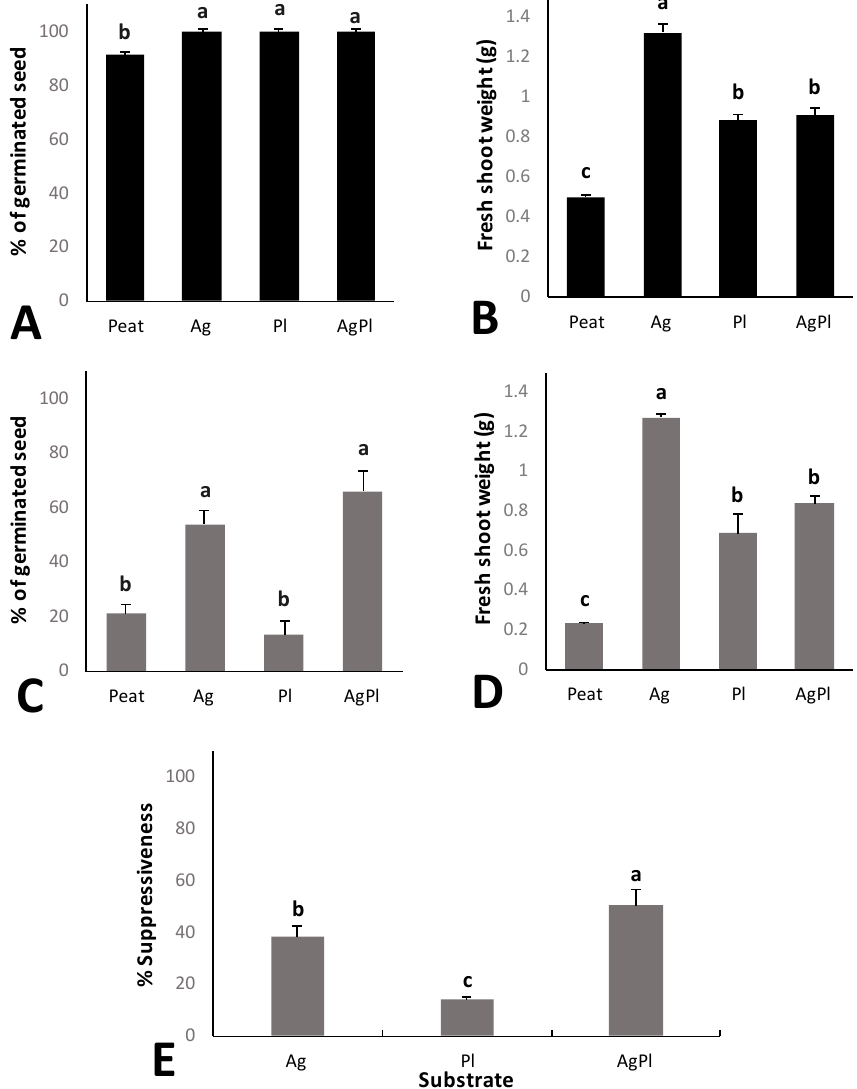
Figure 2. Germinated seed percentage ( A ) and fresh shoot weight ( B ) of red baby leaf lettuce plants without pathogen. Germinated seed percentage with P. irregulare ( C ) and fresh shoot weight ( D ) of red baby leaf lettuce plants with P. irregulare . Suppressiveness index (%) against P. irregulare ( E ). Error bars represent the standard errors. Values with the same letter do not differ significantly according to Tukey’s test ( α < 0.05). Compost growing media of 100% peat, and peat with 100% A. bisporus ( Ag), 100% P. ostreatus (Pl), or 70% A. bisporus : 30% P. ostreatus (AgPl) added at a 1:4 compost:peat ratio.